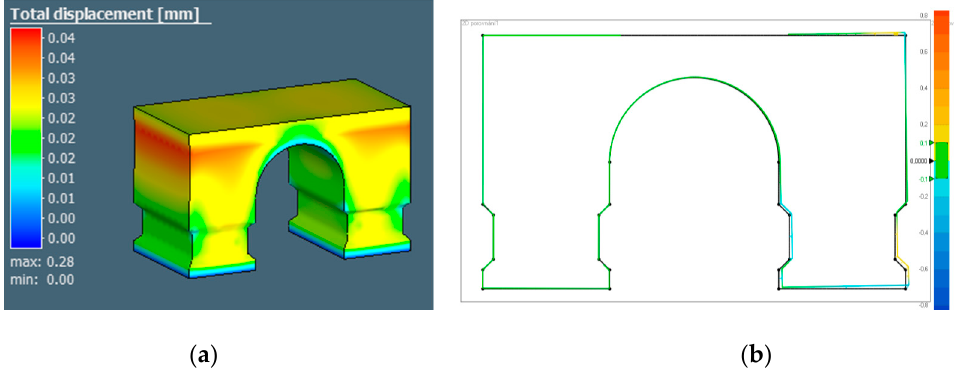
Figure 3. Total displacement done by simulation ( a ); comparison of simulated model and original model ( b ).